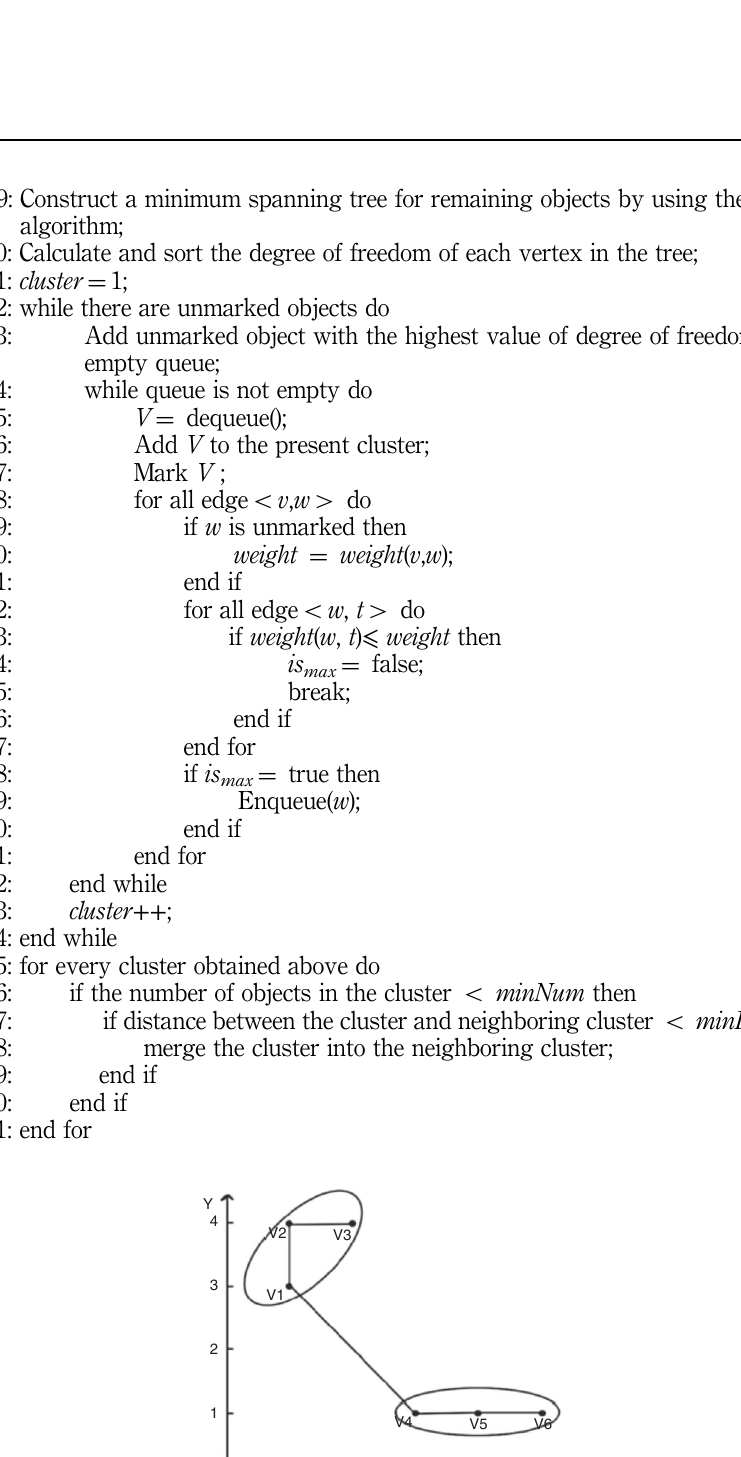
Figure 3. Data after